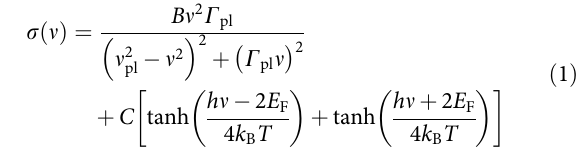
Fig. 1d: above 3,000 cm (cid:2) 1 , s ( n ) increases saturating at higher frequency. This absorption, like in single-layer graphene, can be associated with intercone electronic transitions. The small narrow peak around 1,600 cm (cid:2) 1 roughly coincides with the graphene G phonon which becomes infrared active probably due to disorder. In the following we do not discuss this spectroscopic feature. At low frequency, where for a single layer non patterned graphene having a finite Fermi energy one would expect a Drude absorption, NPG instead exhibits a peak at a finite frequency. This peak, which has been also observed in single-layer disordered graphene 20 , will be attributed (see below) to localized surface plasmons in the underlying graphene layers, where the localization and extra wavevector are provided by the nano-scale porosity. This observation is evidence of graphene plasmons in a 3D porous nanostructure. Analytical model . The plasmon and the interband transition are separated by a broad minimum as the Dirac intercone electronic transitions are forbidden for photon energies below the Fermi energy (Pauli-blocking). Thus to separate the plasmon absorption from the interband transition, and tracing the plasmon char- acteristic frequency versus the Fermi energy and the pore size, we fit the optical conductivity through the sum of two components: a Lorentz oscillator, which describes the low-frequency peak, plus the conventional graphene interband term 21,22 :